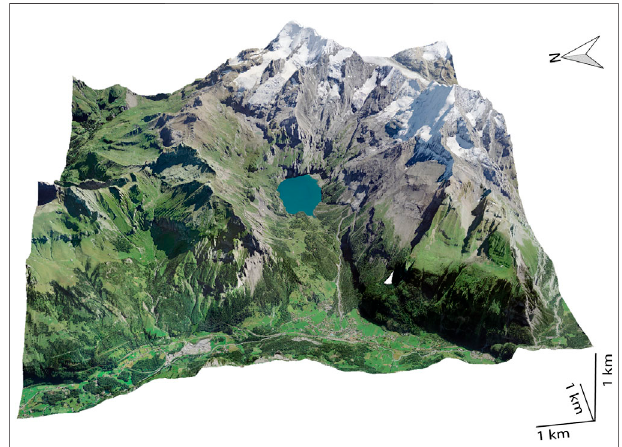
FIGURE 5 | Visualization of Lake Oeschinen (Swissimage Orthophoto using base heights of SwissALTI3D: copyright Swisstopo).